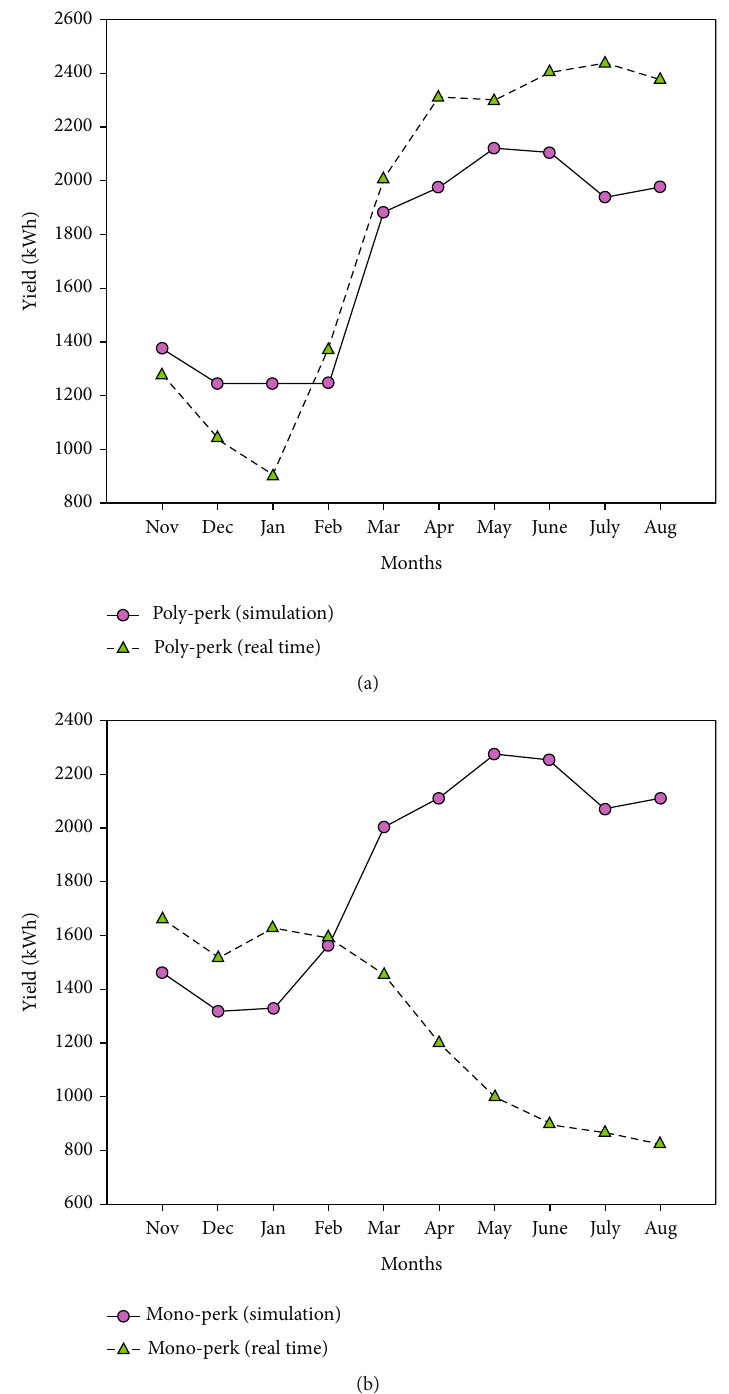
Figure 3: Comparison of yield obtained from simulation and real-time systems: (a) yield obtained from polyperk PV modules; (b) yield obtained from monoperk PV